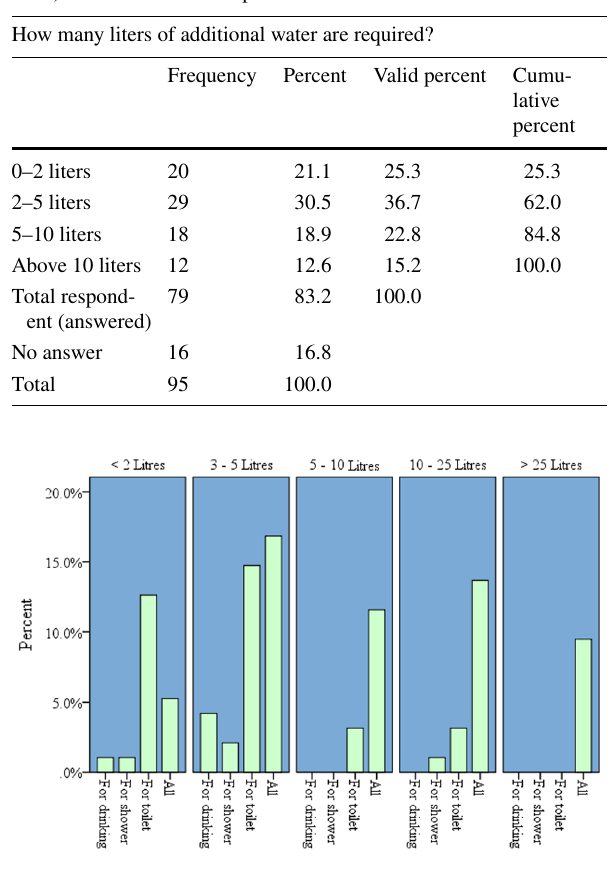
Fig. 6 The water required (in liters) for different purposes in percent- age before the COVID-19 pandemic existed